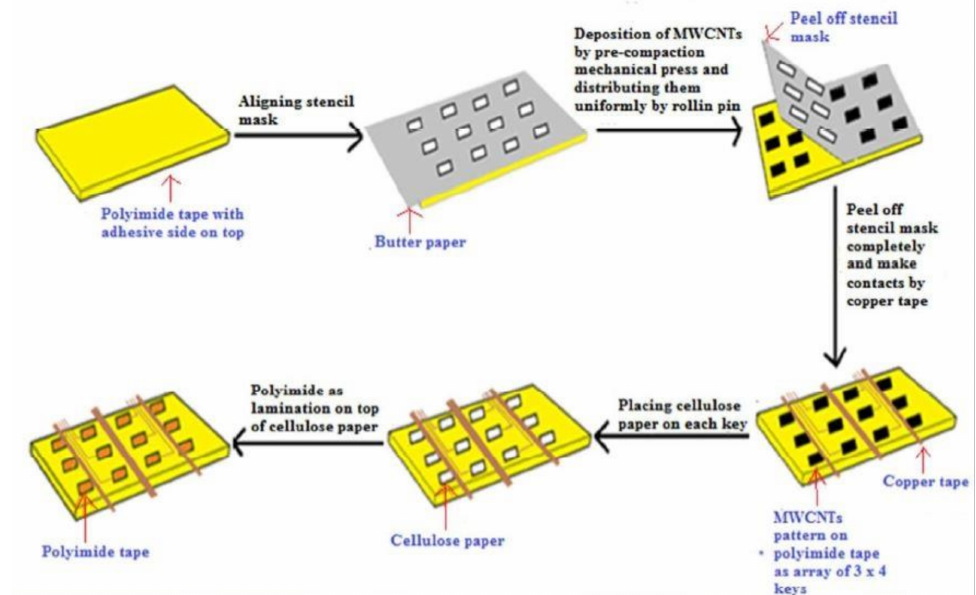
Figure 3. Schematic diagram of the fabrication of the polymide (PI)/cellulose/MWCNT-based strain sensors [101]. Reproduced from Sahatiya, P.; Badhulika, S. Solvent-free fabrication of